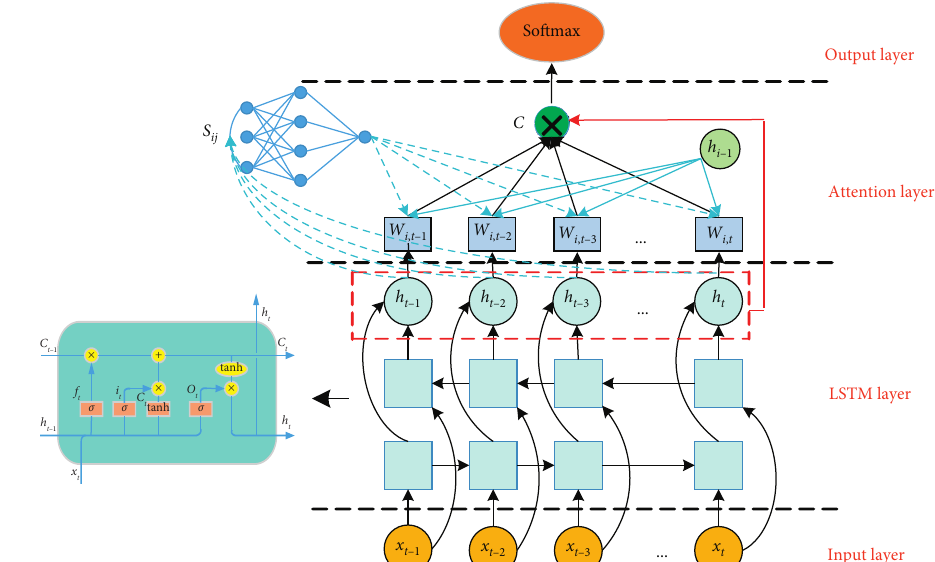
Figure 8: Attention-LSTM prediction model.